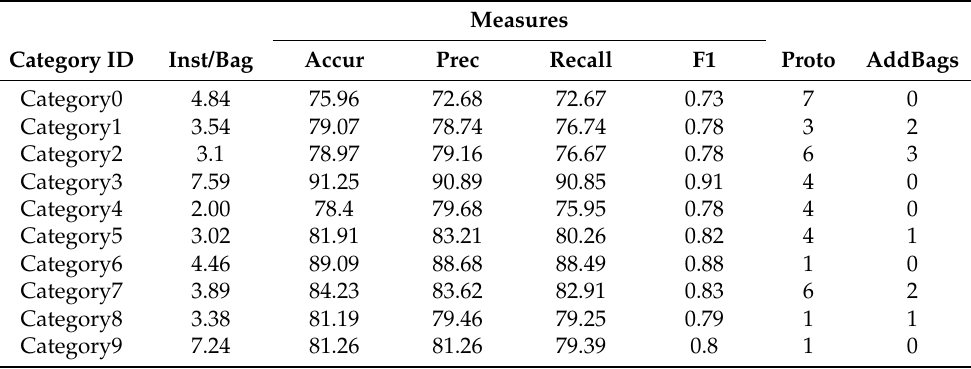
Table 5. Classification results using MILTree-Med on the Corel Dataset.